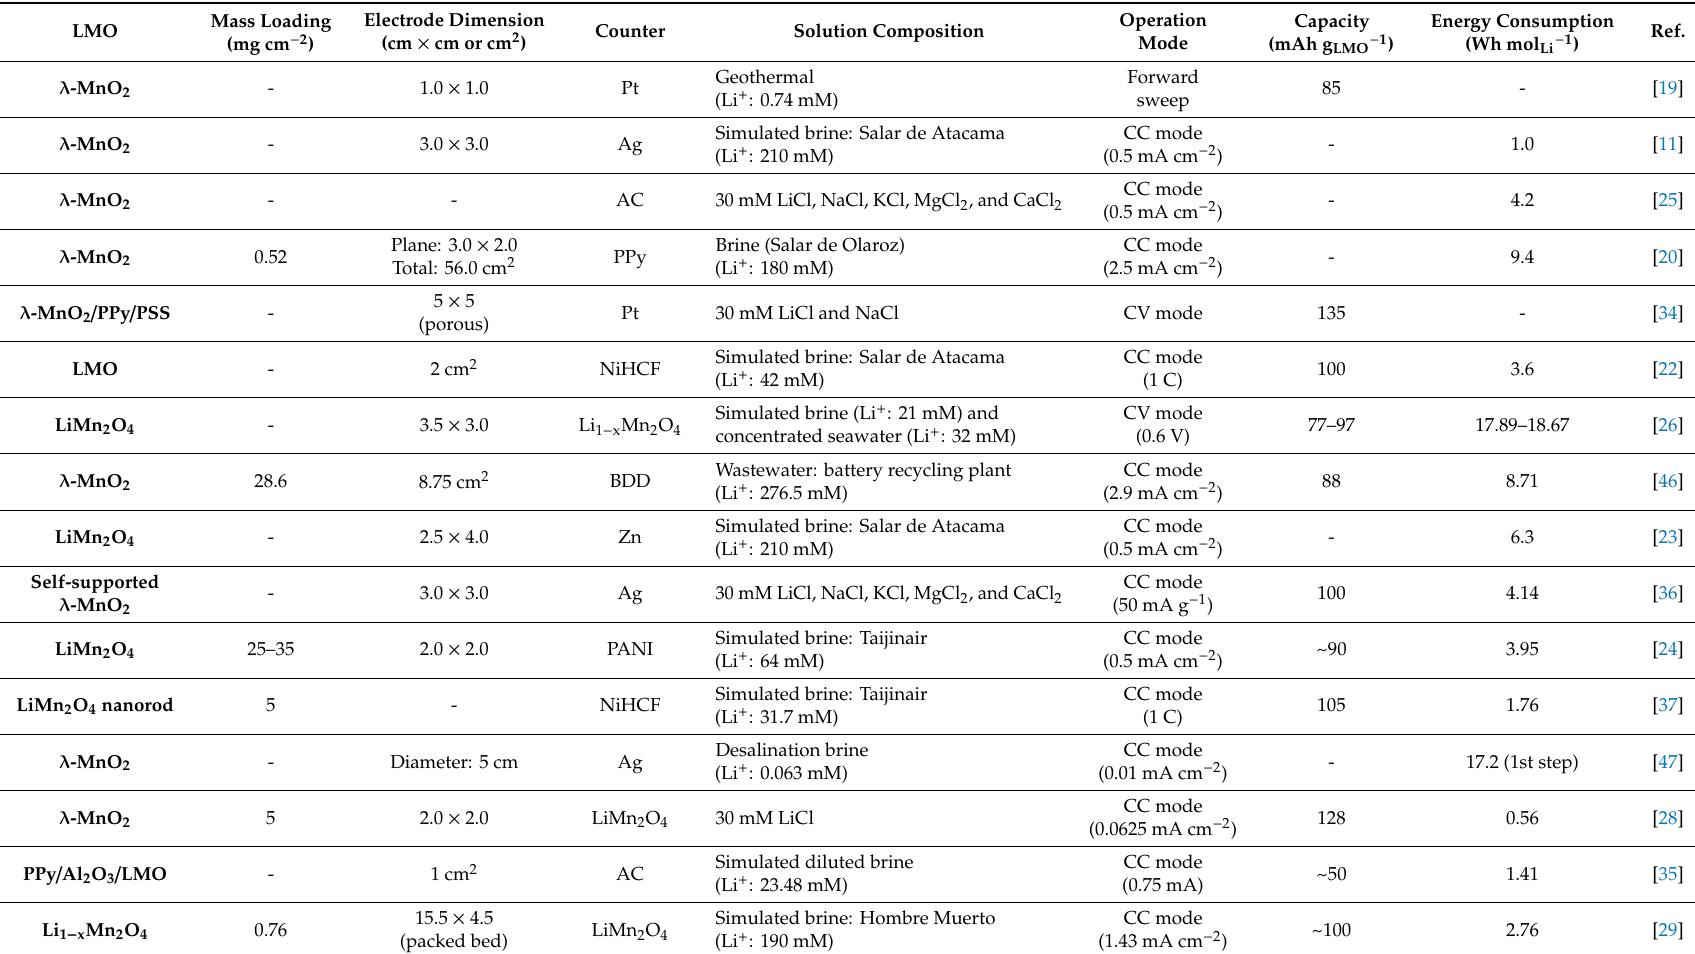
Table A1. Performance of the ELR system using LiMn 2 O 4 (LMO)